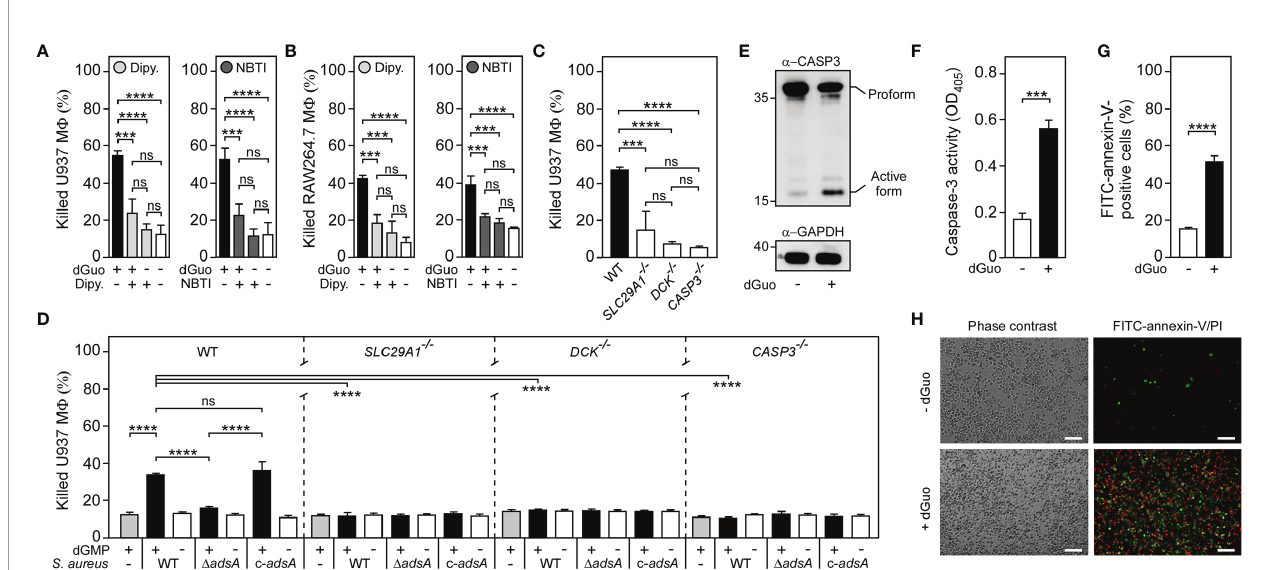
FIGURE 4 | Staphylococcal deoxyguanosine kills macrophages by targeting the purine salvage pathway-apoptosis axis. (A, B) Survival of wild-type (WT) U937- derived macrophages (M Ф ) (A) or murine RAW264.7 M Ф (B) exposed to dGuo in the presence (+) or absence (-) of 10 µM dipyridamole (Dipy.) or nitrobenzylthioinosine (NBTI), both inhibitors of hENT1. Cells were also exposed to the inhibitors only or left untreated. (C, D) Survival of WT U937-derived M F and their SLC29A1 − / − , DCK − / − , or CASP3 − / − variants after treatment with dGuo (C) or after treatment culture medium (RPMI 1640) that had been conditioned by incubation with either wild- type (WT) S. aureus Newman, its adsA mutant ( D adsA ), or the complemented adsA variant (c- adsA ) in the presence (black bars) or absence (white bars) of dGMP. Controls included culture medium that had been conditioned by incubation with dGMP only (gray bars) (D) . (E) Immunoblotting of lysates obtained from dGuo- exposed (+) or untreated (-) WT U937-derived M F with caspase-3 and GAPDH-speci fi c antibodies ( a -CASP3 and a -GAPDH, respectively). GAPDH was used as a loading control. Numbers to the left of blots indicate the migration of molecular weight markers in kilodaltons. (F) Lysates of dGuo-exposed (+) or untreated (-) WT U937-derived M F were analyzed for caspase-3 activity using a colorimetric assay. (G, H) Analysis of dGuo-dependent induction of apoptosis in WT U937-derived M F via FACS (G) or immuno fl uorescence microscopy (H) . dGuo-exposed (+) or untreated (-) M f were stained using FITC-annexin-V/PI and analyzed as indicated (see also Supplementary Figure 5 ). White bars depict a length of 100 m m. Representative images are shown. 80 µM (E) , 160 µM (A, C, F – H) , or 320 µM (B) of dGuo was used to treat the cells. Cell survival rates were analyzed 24 h (A, C, D) or 48 h (B) post-treatment. Induction of apoptosis was analyzed 18 h (F) or 24 h (E, G, H) post-treatment. Data are the mean (± standard deviation [SD]) values from three independent determinations. Statistically signi fi cant differences were analyzed with one-way analysis of variance (ANOVA) and Tukey ’ s multiple-comparison test (A – D) or by a two-tailed Student ’ s t-test (F, G) or; ns, not signi fi cant ( P ≥ 0.05); *** P < 0.001; **** P <